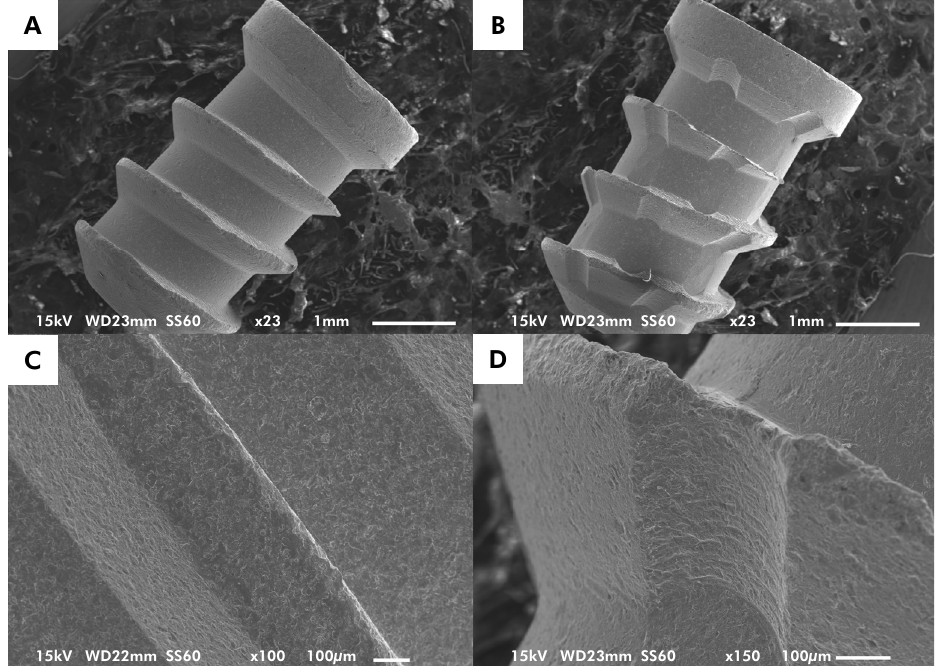
Figure 1. Stereo microscopy of the